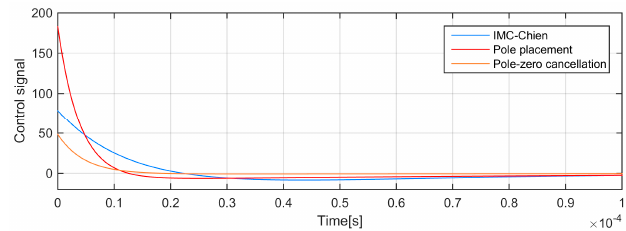
Figure 13. Simulated step responses using IMC-Chien method, the pole placement method and pole-zero control method in the continuous-time case: output voltages and control signals. Table 3. Phase margin variations from continuous to discrete-time control using backward Euler’s discretization